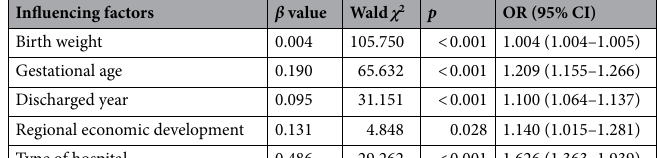
Influencing factors β value Wald χ 2 p Birth